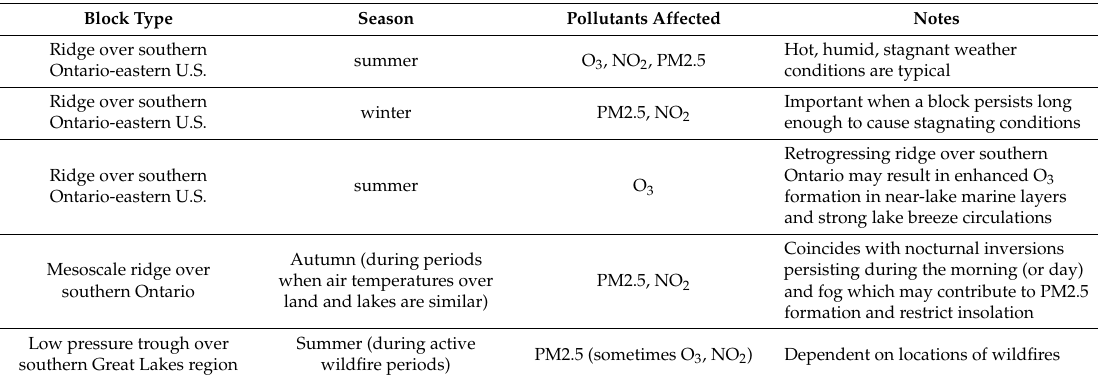
Figure S1: Sea surface temperature anomaly, 21 June 2003. Figure S2: Composite mean MSLP, 21–25 June 2003. Figure S3: Upper-air soundings at Detroit MI, 23 June 2003. Figure S4: Upper-air soundings for Buffalo NY, 23 June 2003. Figure S5: NARR weather at Windsor during 23–26 June 2003. Figure S6: Maximum daily 1-h ozone concentrations during the period May–August 2003. Images supporting the example of 2–7 February 2005. Figure S7: 500 hPa GPH from 2 to 7 February 2005. Figure S8: 500 hPa GPH mean composite anomaly, 1–6 February 2005. Figure S9: MSLP pattern, 1 to 6 February 2005. Figure S10: NARR weather at Sarnia, Ontario during 1–4 February 2005. Images supporting the example of 12 November 2010. Figure S11: 850 hPa temperature, 12 November 2010. Figure S12: Upper air sounding for Buffalo NY, 12Z, 12 November 2010. Figure S13: Great Lakes surface temperatures, 2010. Figure S14: MSLP, 12 November, 12Z, 2010. Images supporting the example of 1 July 2013. Figure S15: Composite mean 850 hPa GPH 28 June–2 July 2013. Figure S16: Winds and GPH at 850 hPa level 29 June 2013. Figure S17: NASA Worldview true color map showing detected fires, 29 June 2013. Figure S18: MSLP pattern during 1 July 00Z to 3 July 12Z, 2013. Figure S19: Streamline pattern at 925 hPa level during 2–3 July 2013. Images supporting the example of 15 July 2013 Figure S20: Temperatures at 850 hPa level, 14 to 19 July, 2013. Figure S21: MSLP pattern, 14 to 19 July 2013. Figure S22: 850 hPa GPH with streamlines, 14 to 16 July 2013. Figure S23: MSLP, July 14 09Z and 18Z, 15 and 16, 2013. Figure S24: Visible-wavelength satellite, afternoon of 15 July 2013. Figure S25: 48-h Back trajectories ending at Toronto on afternoon of 15 July 2013. Figure S26: 48-h Back trajectories ending at Toronto on afternoon of 16 July 2013. Figure S27: Peak ozone AQI during 13 July 2013. Figure S28: Peak ozone AQI during 14 July 2013. Figure S29: Peak ozone AQI during 15 July 2013. Figure S30: Peak ozone AQI during 16 July